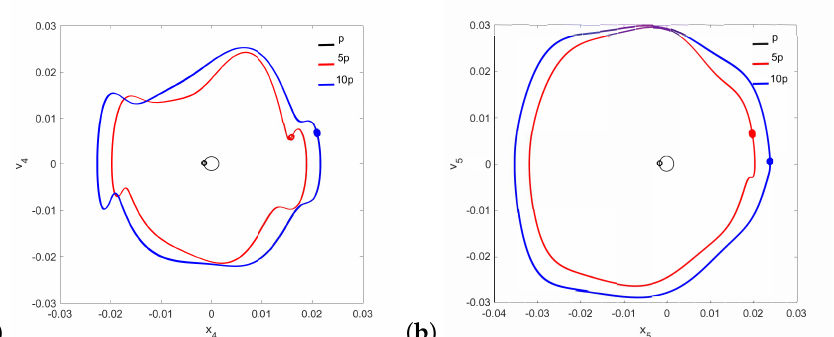
Figure 12. Phase diagrams of FMT motion in the pathological ear for γ 24 = 1 × 10 5 : the can ( a ) and the magnet ( b ).